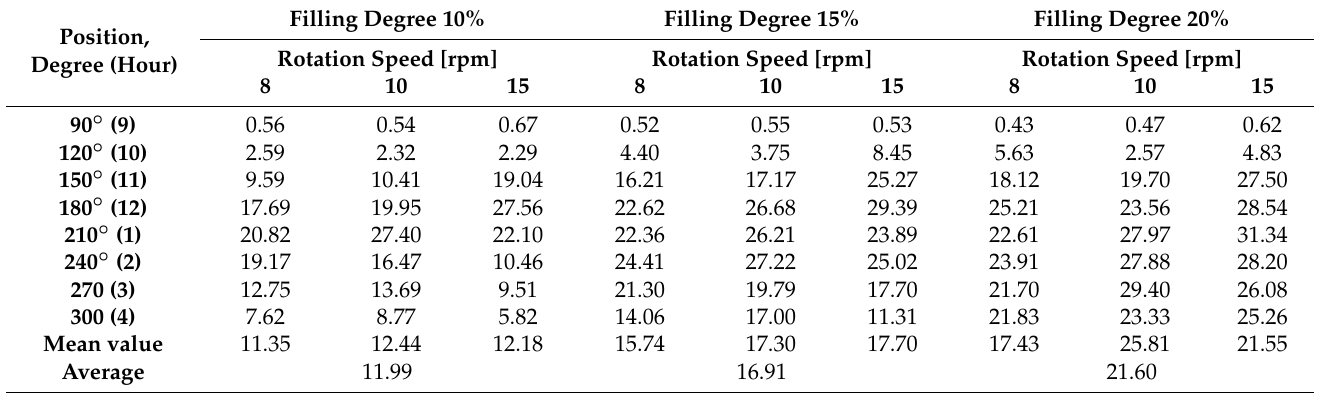
Table 1. The percentage of area occupied by the particles ( AOR %) for L-type flights.